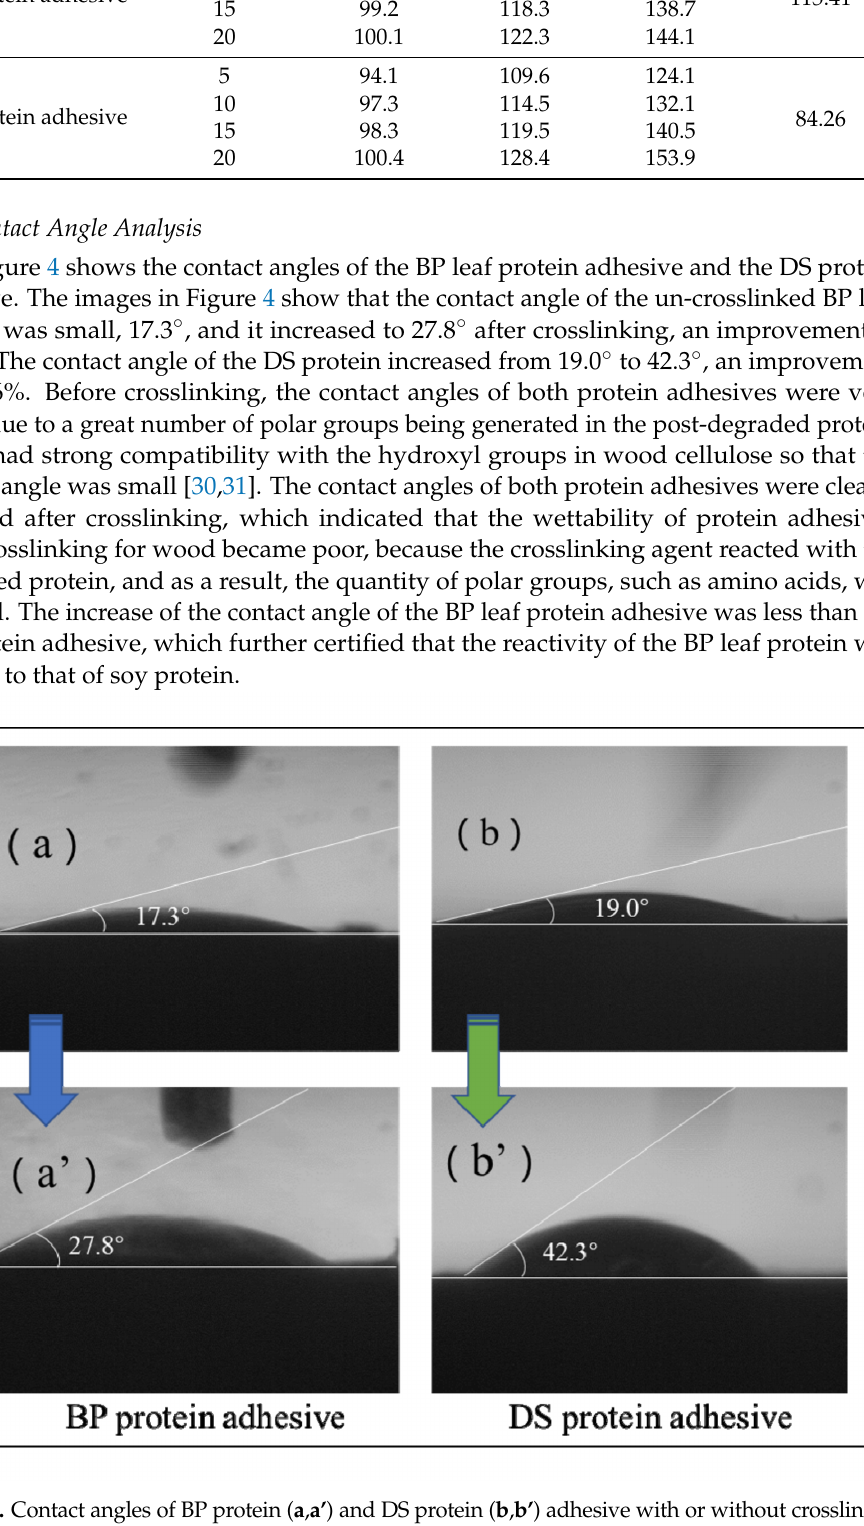
Figure 4. Contact angles of BP protein ( a , a’ ) and DS protein ( b , b’ ) adhesive with or without